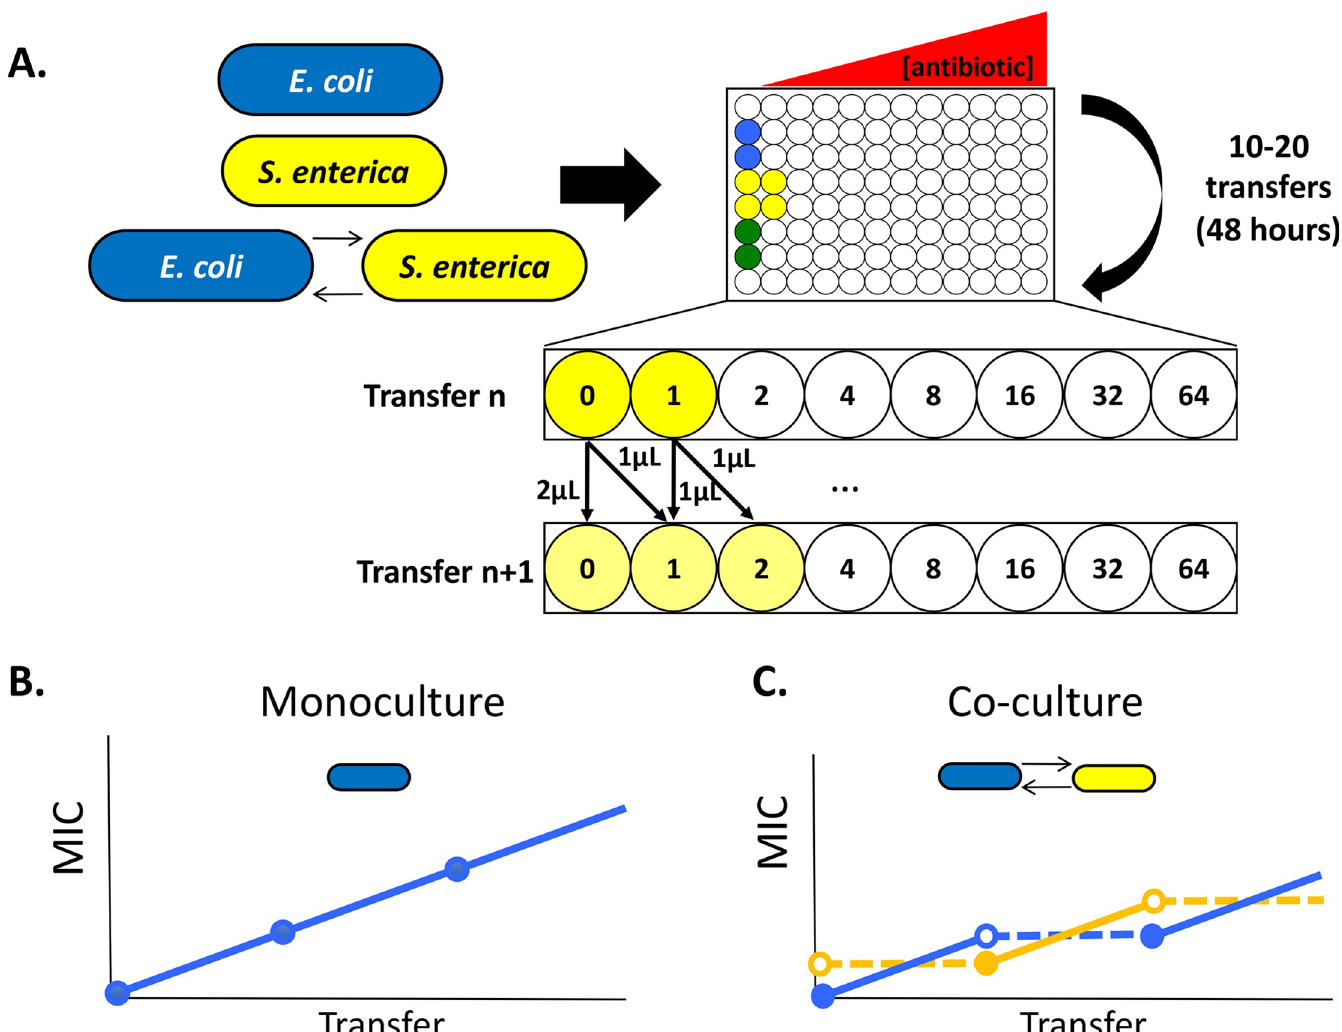
Fig 1. Schematic of experimental setup and expectations. A. Monocultures of E . coli (blue) and S . enterica (yellow), as well as cross-feeding co-cultures (green), were distributed in six replicate populations along an antibiotic gradient in 96-well plates. The antibiotics tested included rifampicin and ampicillin, and the concentration of antibiotic increased twofold at each well. 96-well plates were incubated with shaking at 30˚C for 48 hours, then cells were transferred to fresh medium and antibiotic in a new plate. The transfer regime was to transfer 1 μ L of culture to a fresh well containing the same concentration of antibiotic at which it had previously grown, and 1 μ L to a fresh well containing one concentration step higher antibiotic. At each passage, the OD600 of the plate was measured, as well as species-specific fluorescence (CFP for E . coli , YFP for S . enterica ). B-C. Hypothesis on why time under selection may be sufficient to explain MIC differences between monocultures and co-cultures. B. In monoculture, each species is under selection at every time step, thus selecting for increasing resistance with each passage. C . In obligate co-culture, only the more antibiotic-sensitive species is under selection at a given time, and effective co-culture resistance requires an increase in MIC in both species. This leads to the slower rise in resistance in the co-culture.